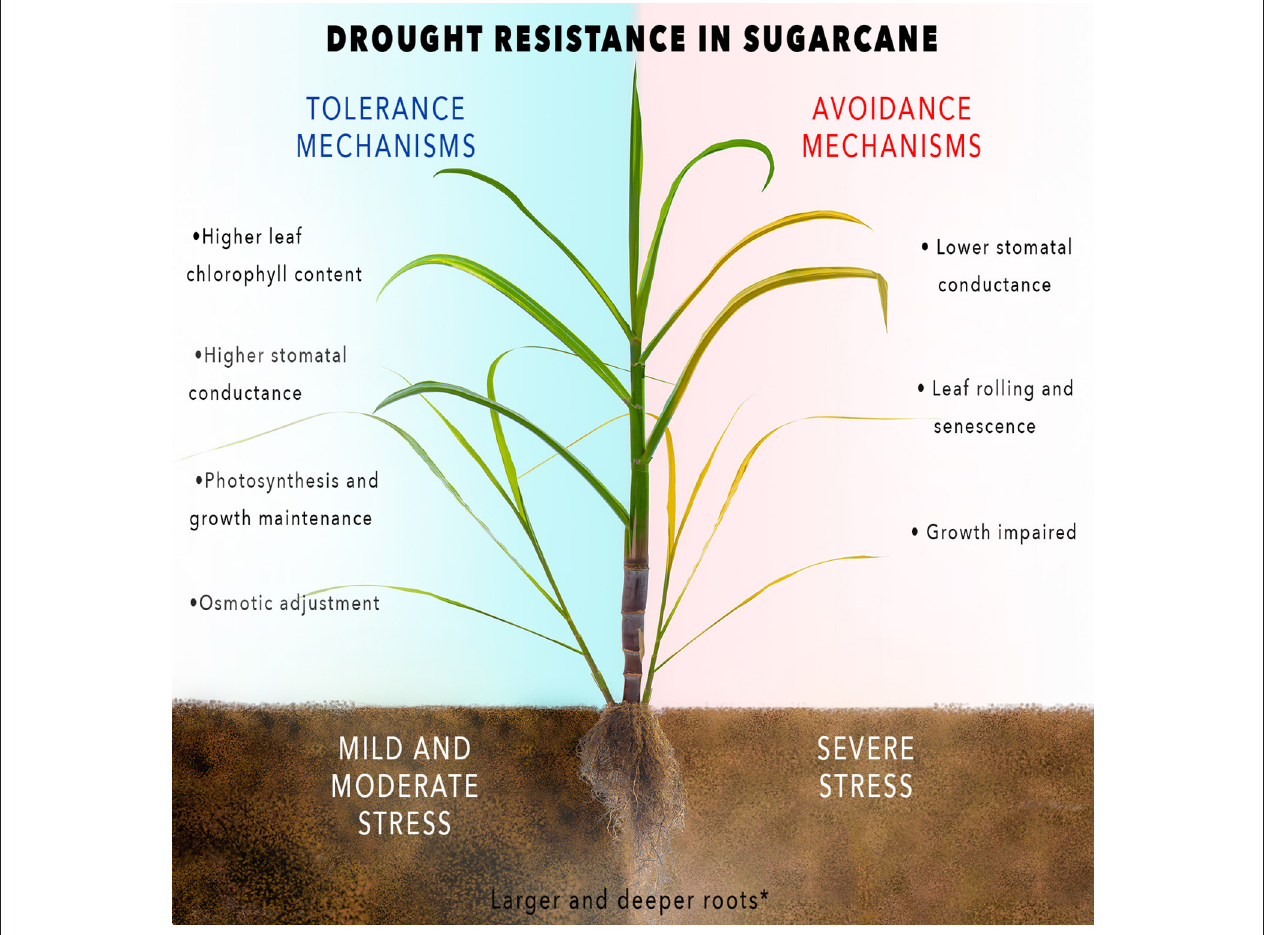
FIGURE 1 | Scheme of sugarcane drought-response